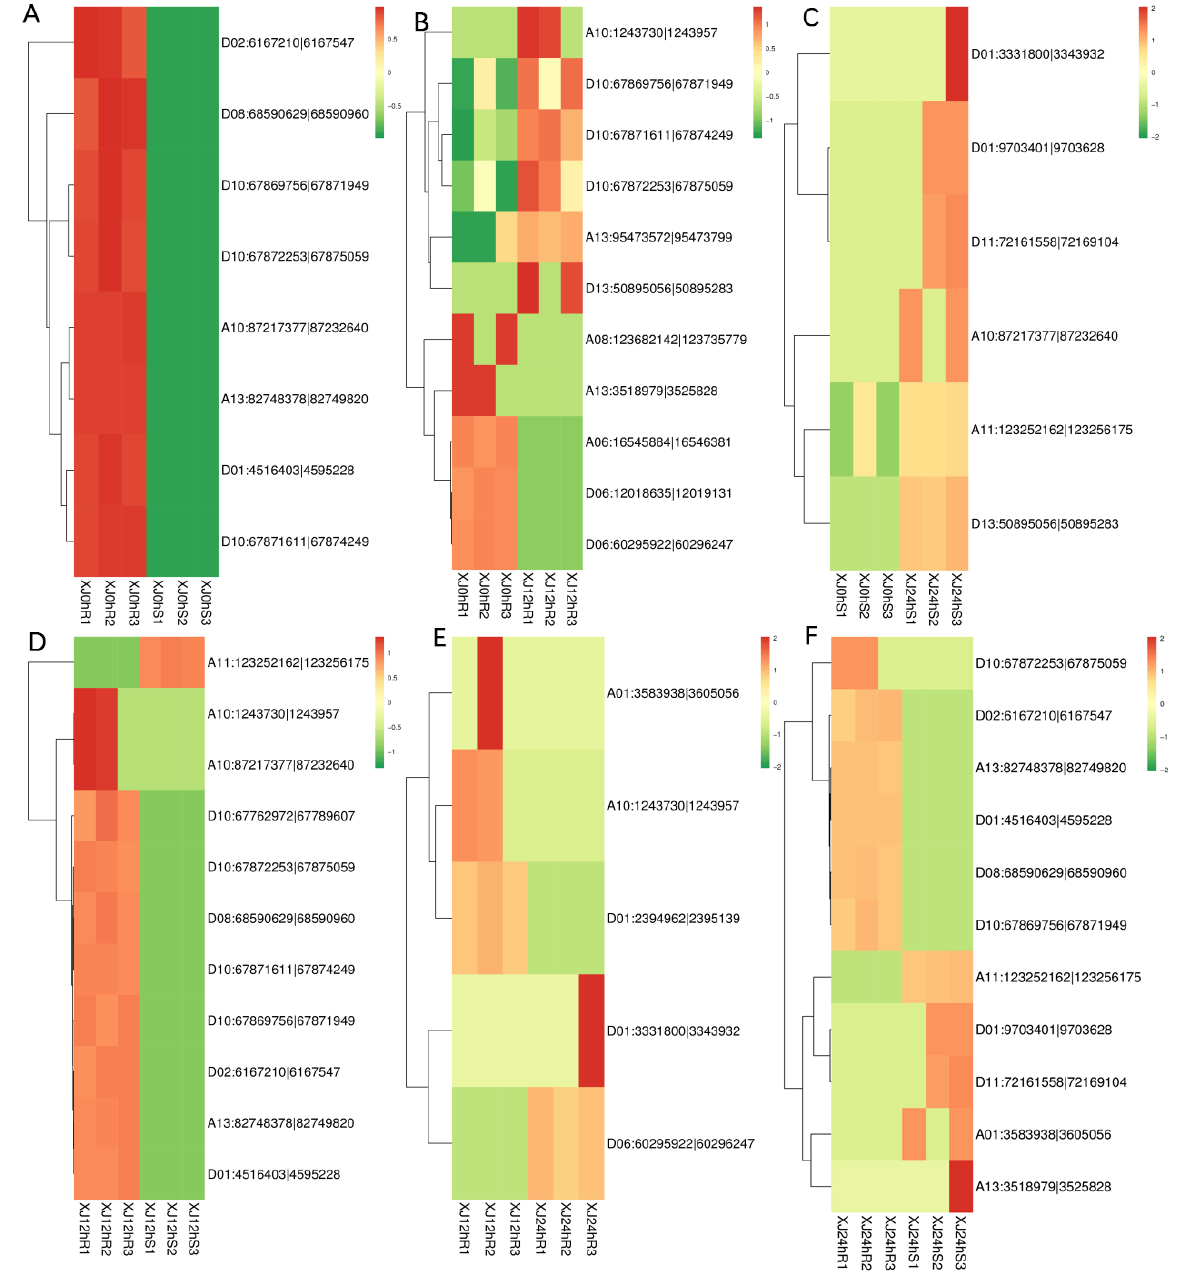
Figure 4. Cluster map of differentially expressed circRNA expression patterns. Note: Different columns in the figure represent different samples, and different rows represent different circRNAs. The colour represents the expression level of the circRNA in the sample (log10SRPBM+0.000001).